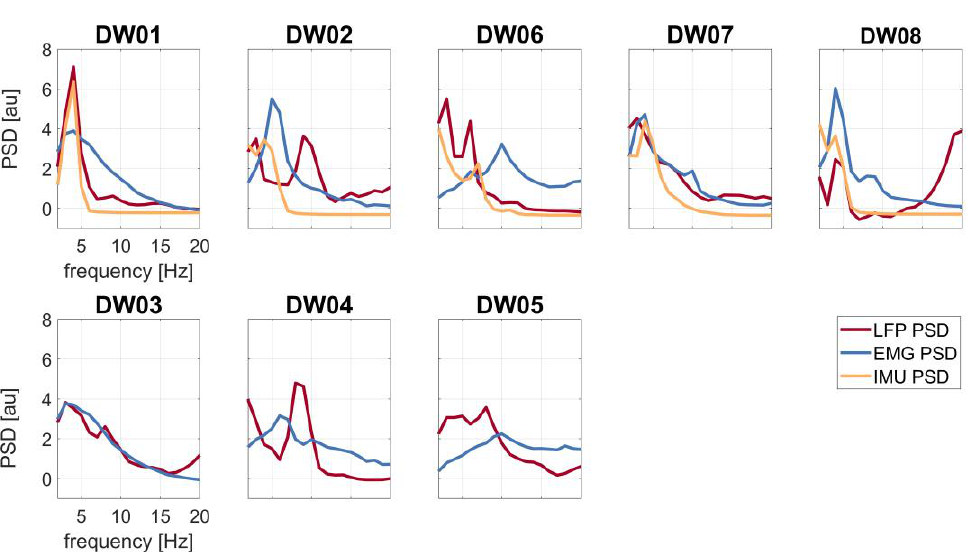
Figure 2. Spectral profiles of the LFP (red line), EMG (blue line), and IMU (yellow line) recordings of all patients. First row: patients with tremor (T+); second row: patients without tremor (T − ). Regression-based removal of IMU signals from LFPs led to power reduction, espe- cially in the theta-alpha band, in all T+ patients (Figure 3). Regression of the EMG signal was instead not affecting LFP theta-alpha peak power except for three patients (DW02, DW06, and DW08) (Figure 3 and Table 2).